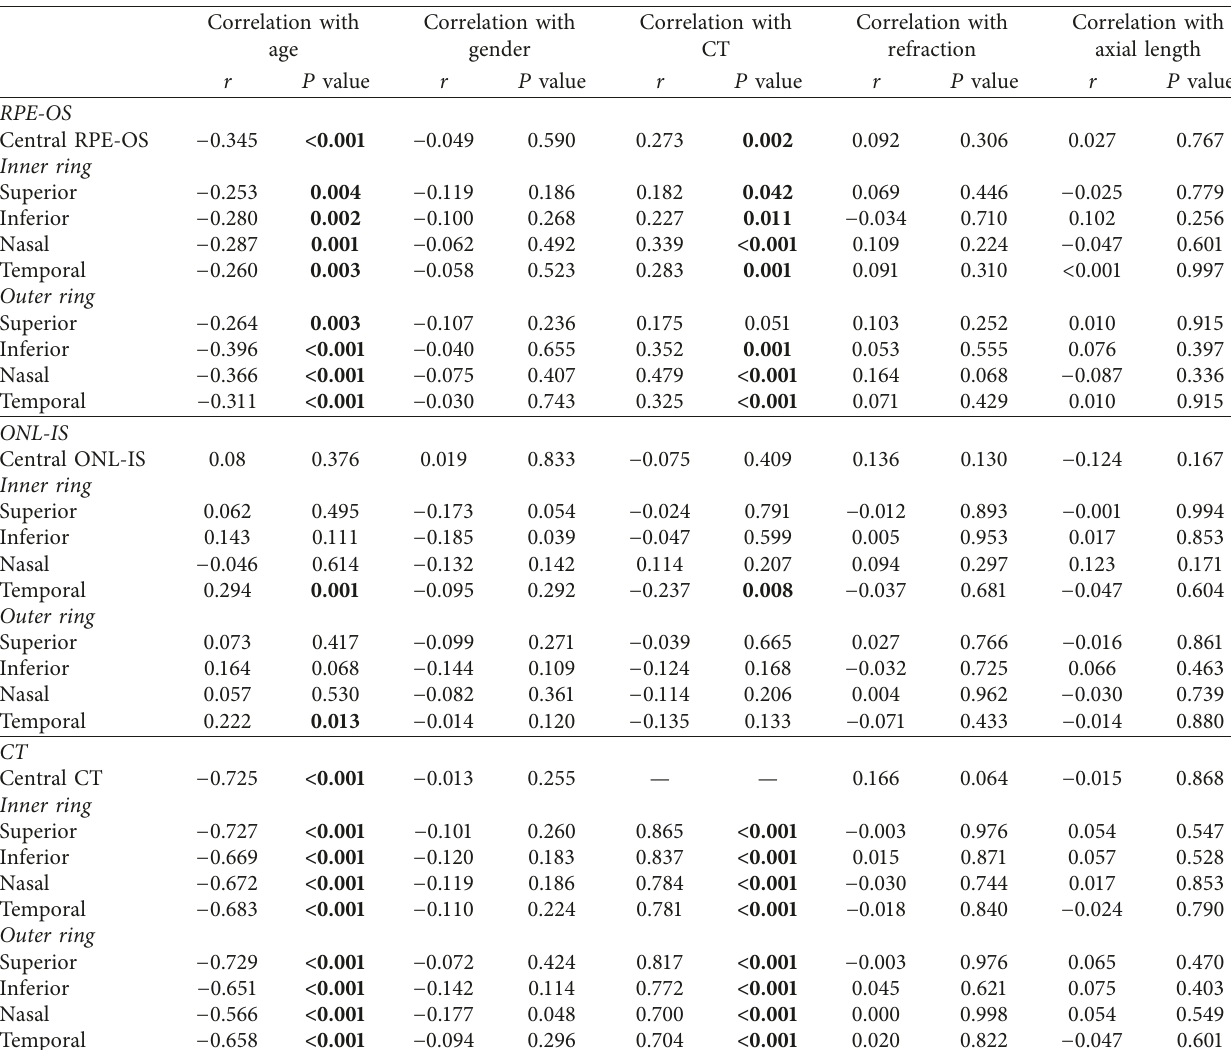
Table 3: Correlation of the 9 ETDRS subfields mean thickness of RPE-OS, ONL-IS, and CT with age, gender, refraction, axial length, and CT.